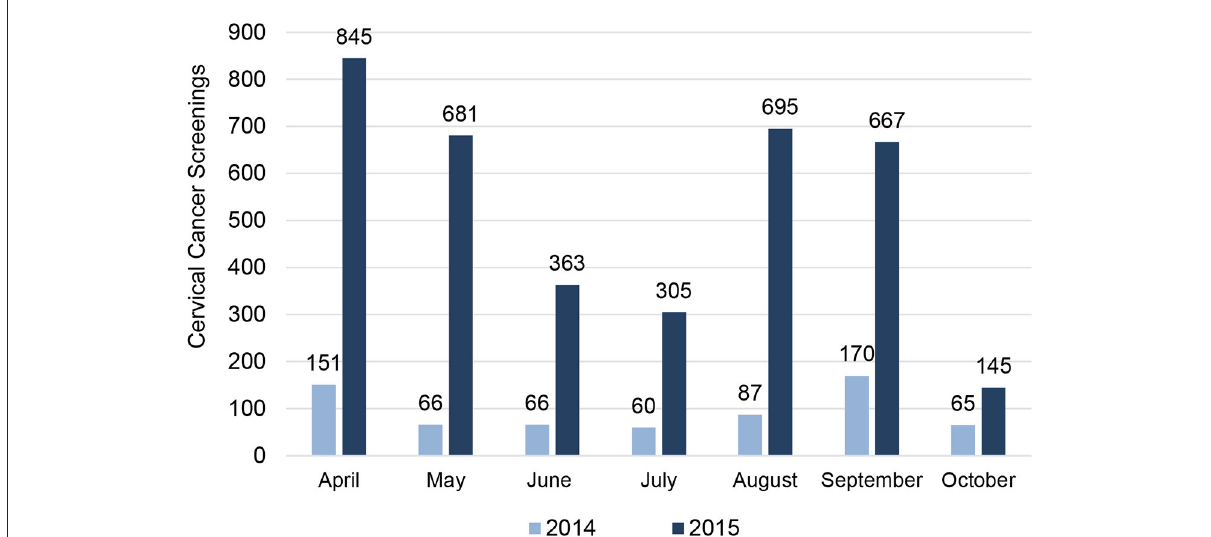
FIGURE3 Comparison of CC screenings at partner sites by Month in 2014 and 2015. There was a five-fold increase in CC screens during the intervention. 3,701 women were screened from April through October 2015 (bars in dark blue), while over the same period in 2014, only 665 screenings were provided at all five sites (light blue bars). The histogram provides a month-by-month report for CC screenings at partner sites. Notable decreases in screens are seen during the months of